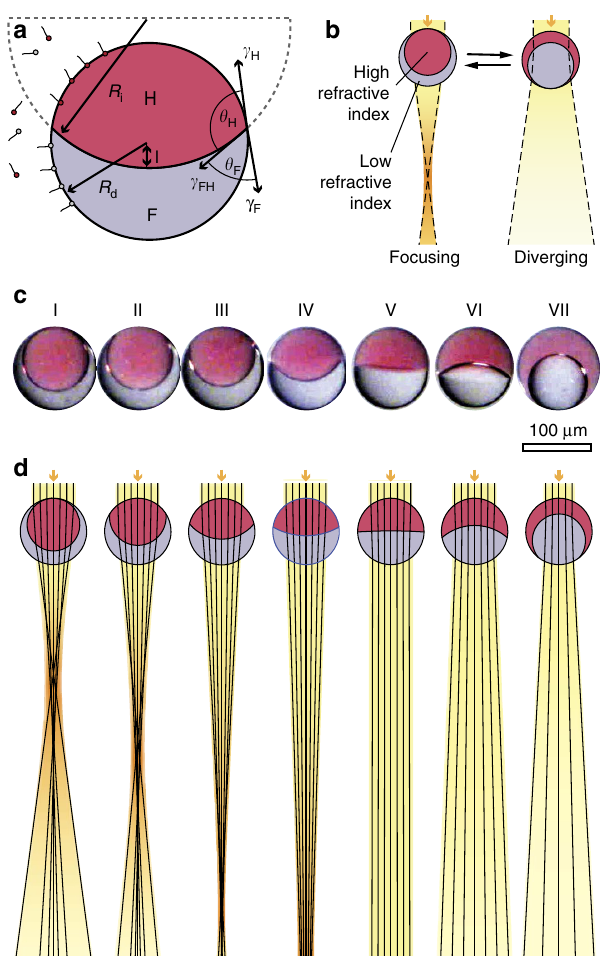
Figure 1 | Concept and modelling of microfluidic emulsion-based compound lenses. ( a ) Geometry of a bi-phase emulsion droplet. The internal curvature R i is determined by the interfacial tensions between hydrocarbon and water g H , fluorocarbon and water g F , and hydro- and fluorocarbon g FH . The distance from the centre of the drop to the internal interface l is constrained by the volume ratio (equation (1)). ( b ) Double emulsions are expected to switch between focusing and diverging geometries. ( c ) Side view optical micrographs of droplets composed of FC-770 (grey) and heptane (red) with varying internal interface curvature. The red colour of the heptane phase results from the incorporation of the dye Sudan Red 7B. ( d ) Corresponding ray-tracing simulations showing the propagation of light rays through the droplets.